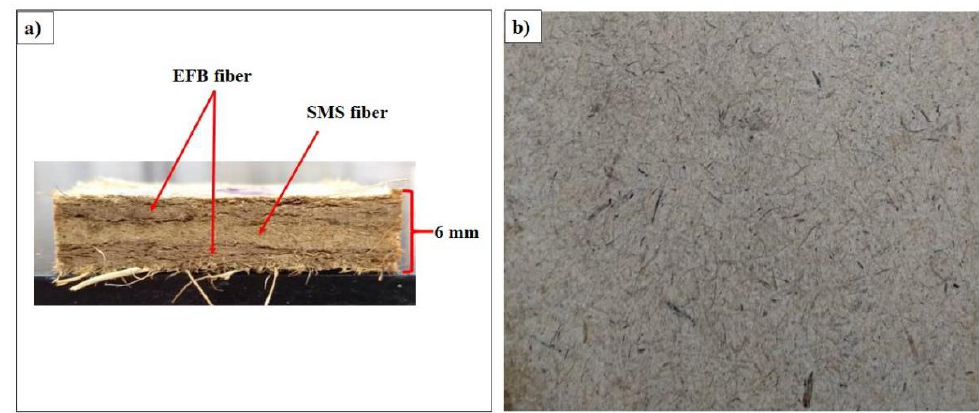
Figure 2. ( a ) Finished samples of sandwich composite panel and ( b ) surface appearance of sandwich composite